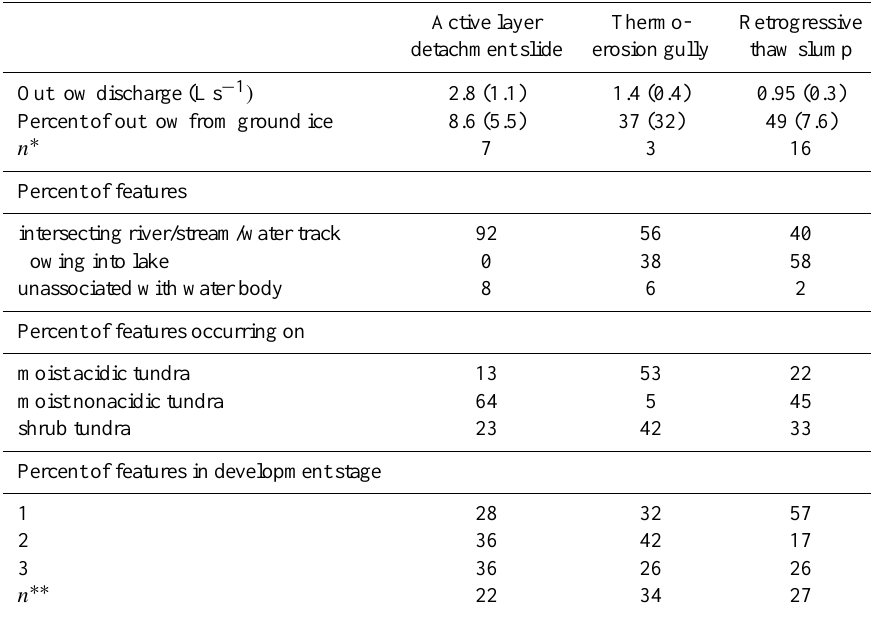
Table 1. Characteristics of upland thermokarst features in study.